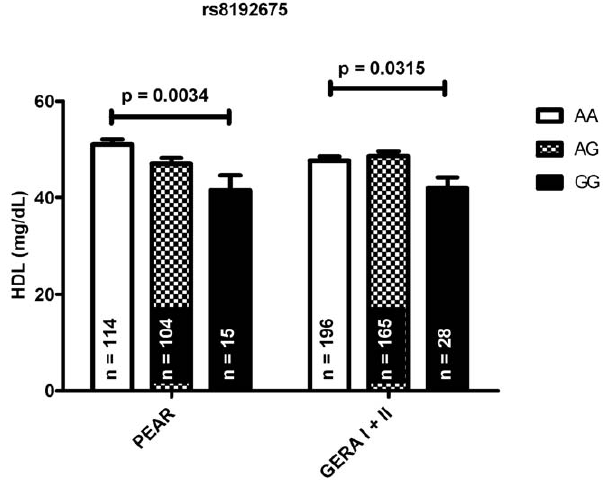
Figure 2. Effects of rs8192675 on HDL levels in PEAR and GERA European Americans. ANOVA was adjusted for age, BMI, and sex and shown as least square mean 6 standard error.